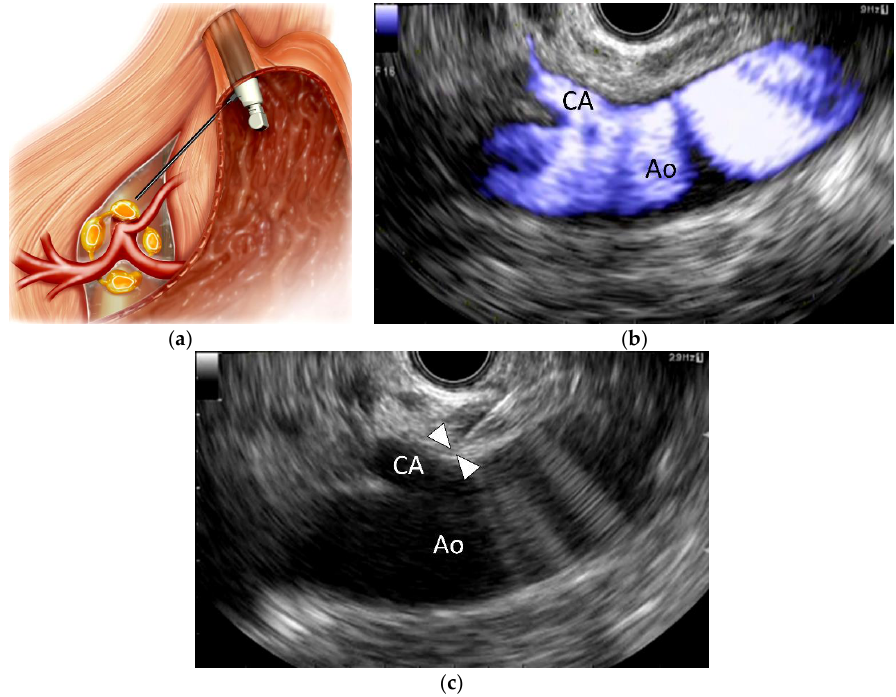
Figure 1. Endoscopic ultrasound-guided celiac plexus neurolysis (EUS-CPN). ( a ) Schematic of EUS-CPN; ( b ) Color flow EUS image from the lesser curvature of the stomach showing a longitudinal view of the aorta (Ao) and celiac artery (CA); ( c ) EUS image of EUS-CPN during needle puncture. A 22-gauge needle was advanced adjacent to the CA origin. Arrowheads indicate the needle tip. Blue: vascular flow.